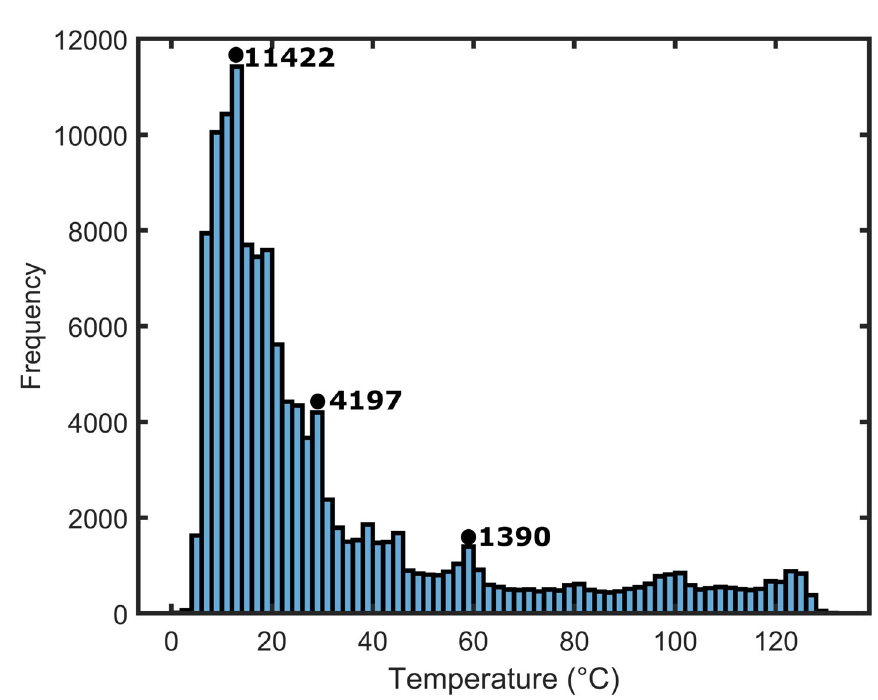
Figure 6. Frequency chart for temperature at the base of the basin.